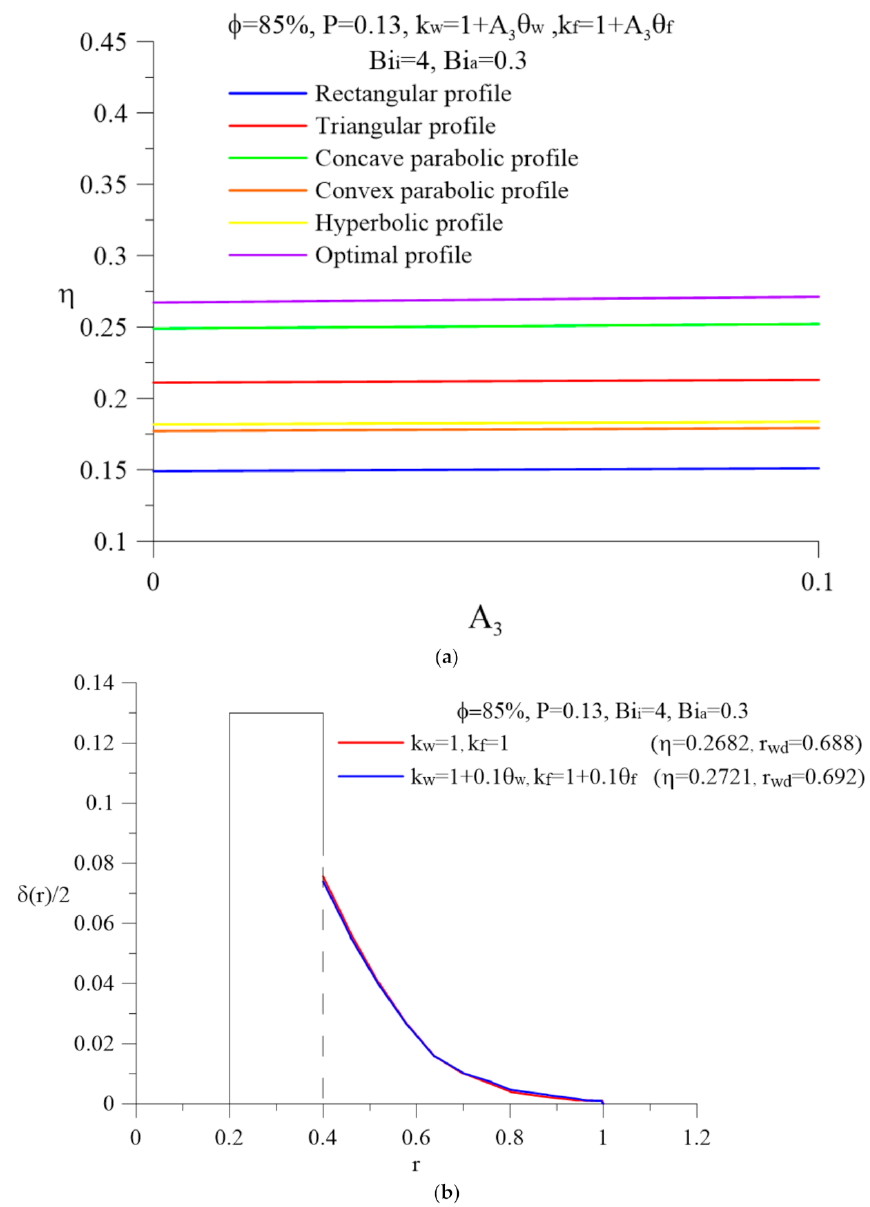
Figure 8. ( a ) The comparisons of η for different types of fins with various k w and k f . ( b ) The estimated optimal shapes fins with various k w and k f